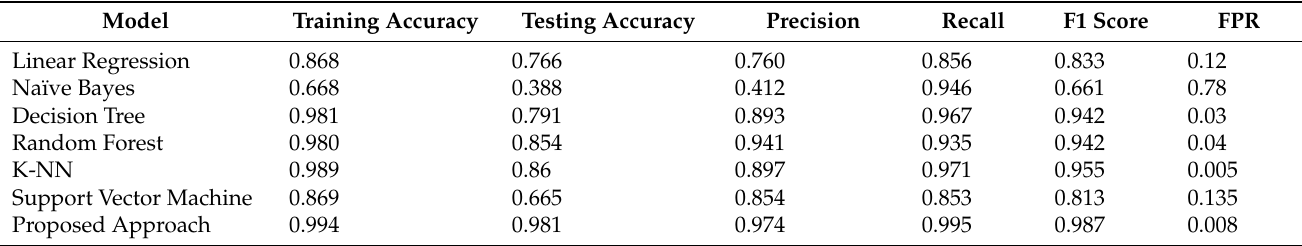
Table 2. Comparison with benchmark